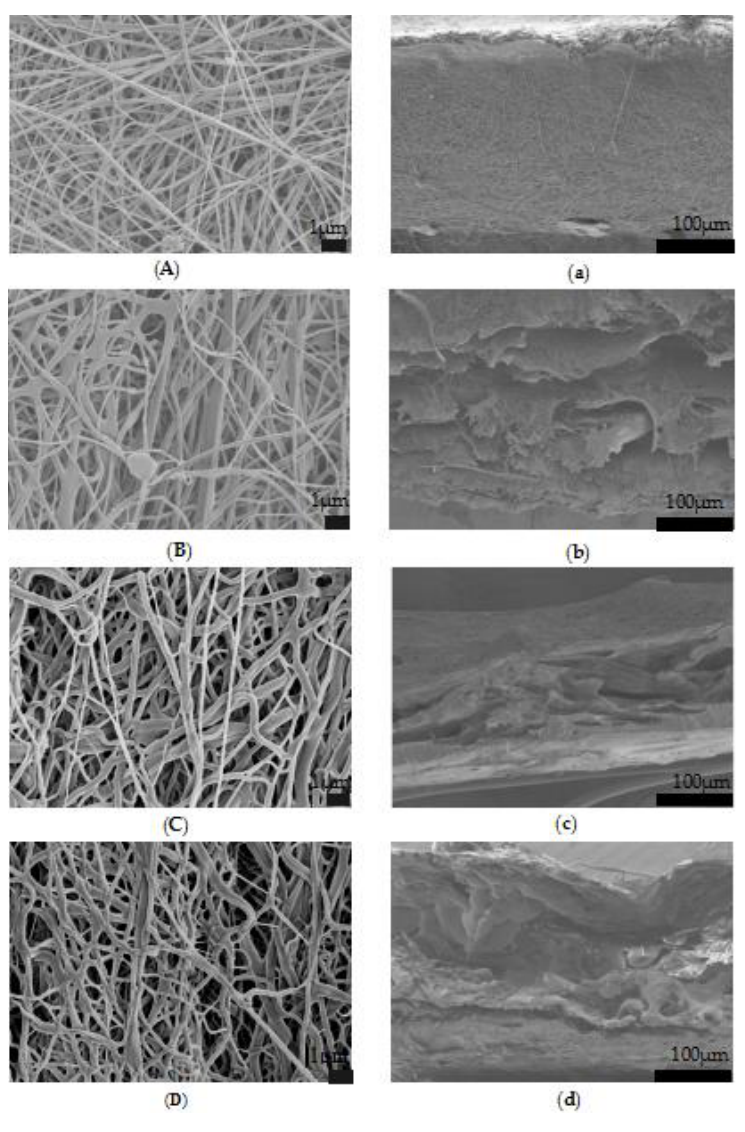
Figure 5. SEM of surface and cross-section of PVA/PEO membranes. ( A )( a ) 8 wt % PVA; ( B )( b ) 8 wt % PVA/3 wt % PEO (90/10); ( C )( c ) 8 wt % PVA/3 wt % PEO (80/20); ( D )( d ) 8 wt % PVA/3 wt % PEO (70/30).